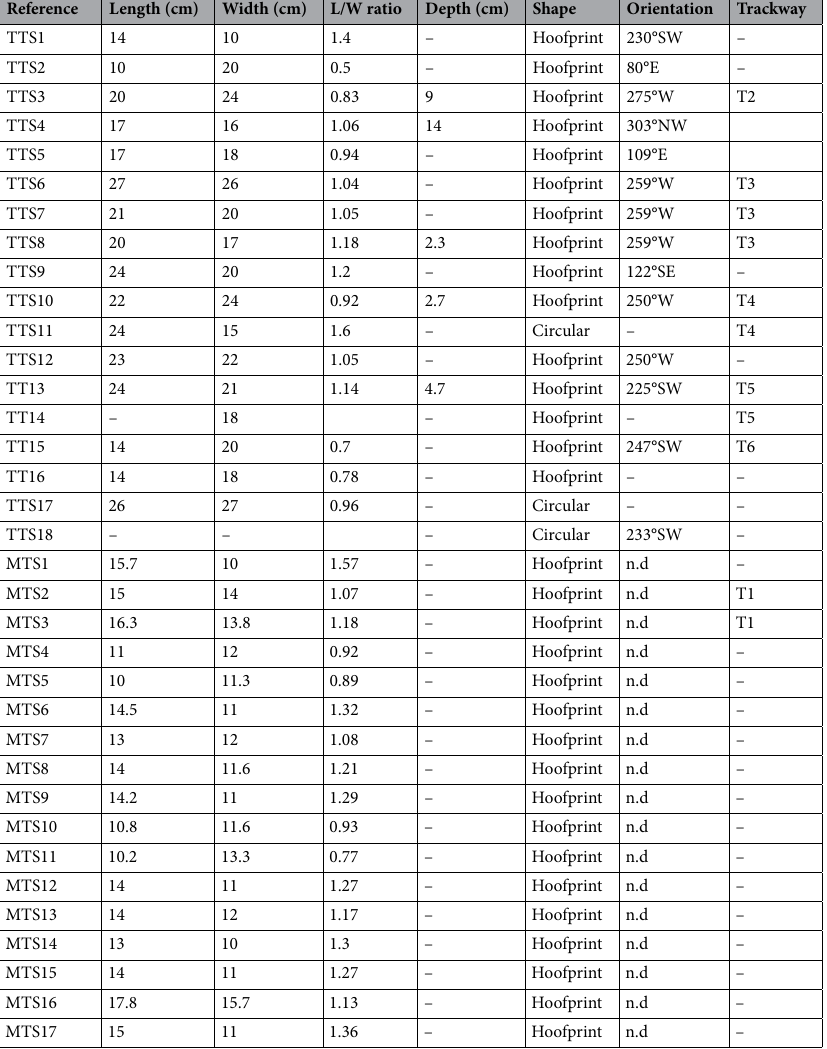
Table 1. Track measurements in the TTS and the